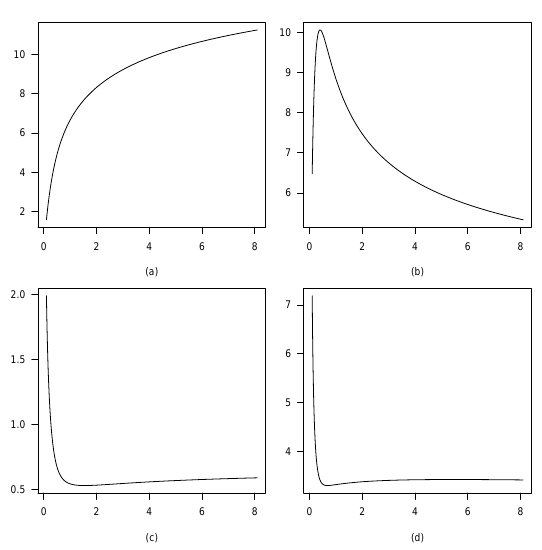
Figure 8 – Mean, in panel (a), variance, in panel (b), skewness, in panel (c), kurtosis, in panel (d), of the power negative binomial distributions { r